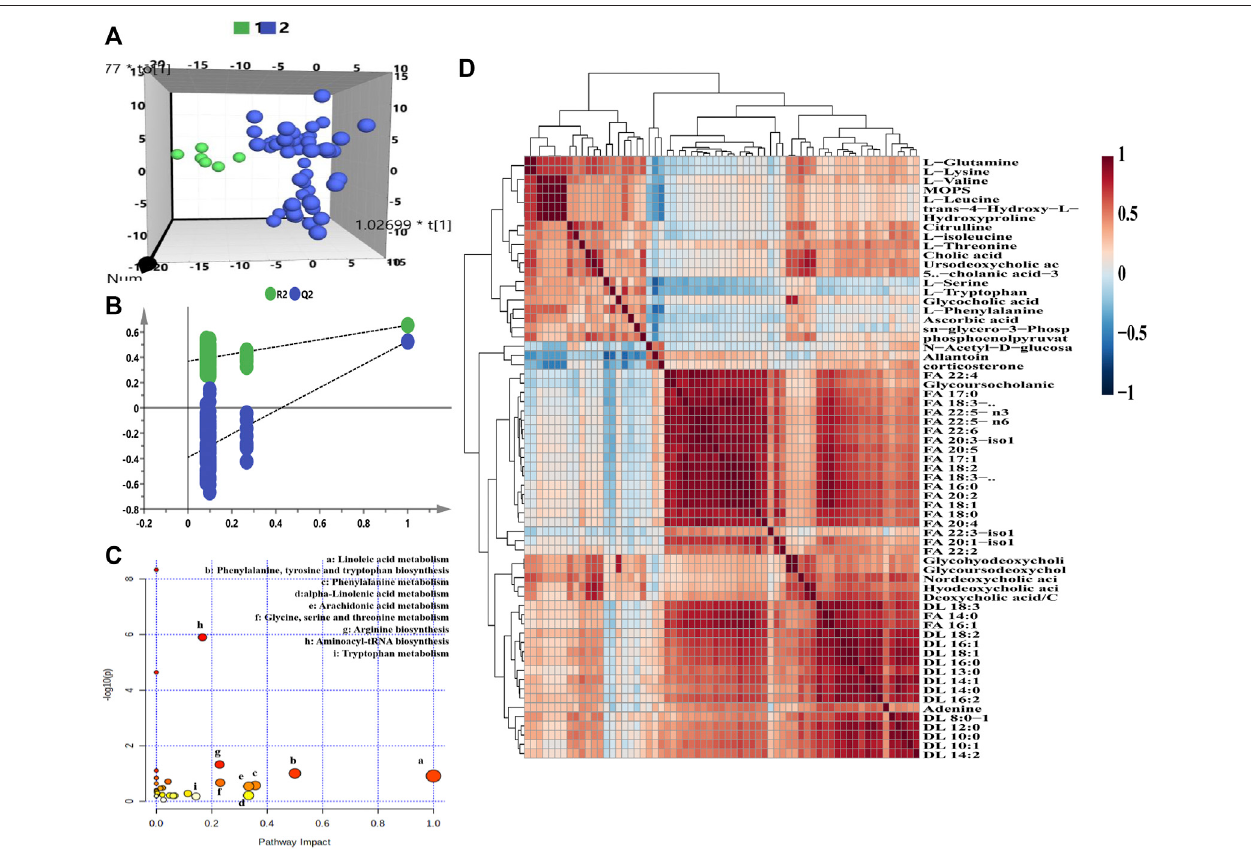
FIGURE 3 | Transversal metabolomics fi ngerprint of remdesivir before and after treatment. (A) OPLS-DA score plot. (B) Random permutation test with 200 iterations. (C) Overview of pathway enrichment analysis of the altered metabolites between pre- and post-dose. (D) HCA of metabolite – metabolite correlation in response to remdesivir